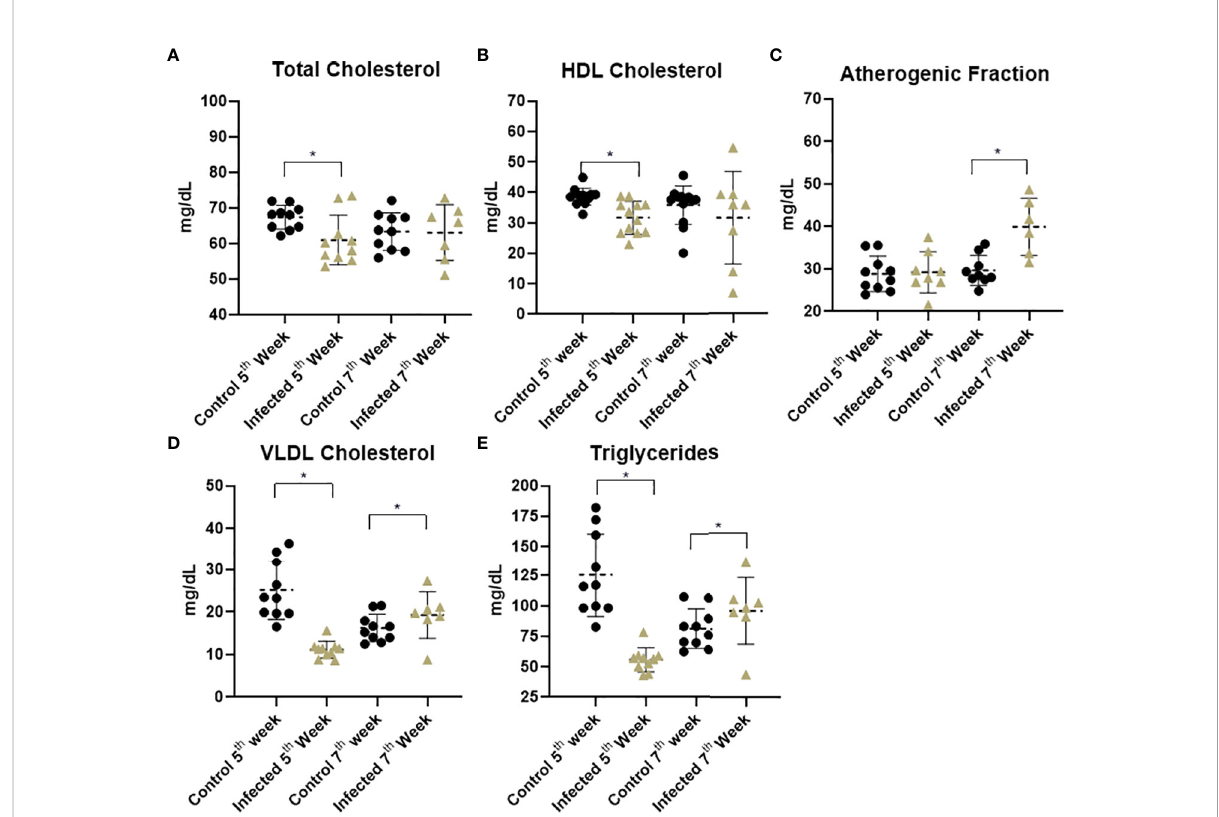
FIGURE 6 Serum lipid pro fi le of experimental groups. Graphics represent the arithmetic means and standard deviations. Asterisks indicate signi fi cant differences between the evaluated conditions (p ≤ 0.05). (A) Total cholesterol content of control and infected mice. (B) HDL cholesterol demonstrated a decrease at 5 th week post infection. (C) Infected mice at 7 th week displayed a signi fi cant increase in the atherogenic fraction. (D) VLDL cholesterol levels declined at 5 th week post infection and increased at the late time point. (E) Triglyceride levels displayed a signi fi cant decrease at 5 th week post infection followed by an increase at the 7 th